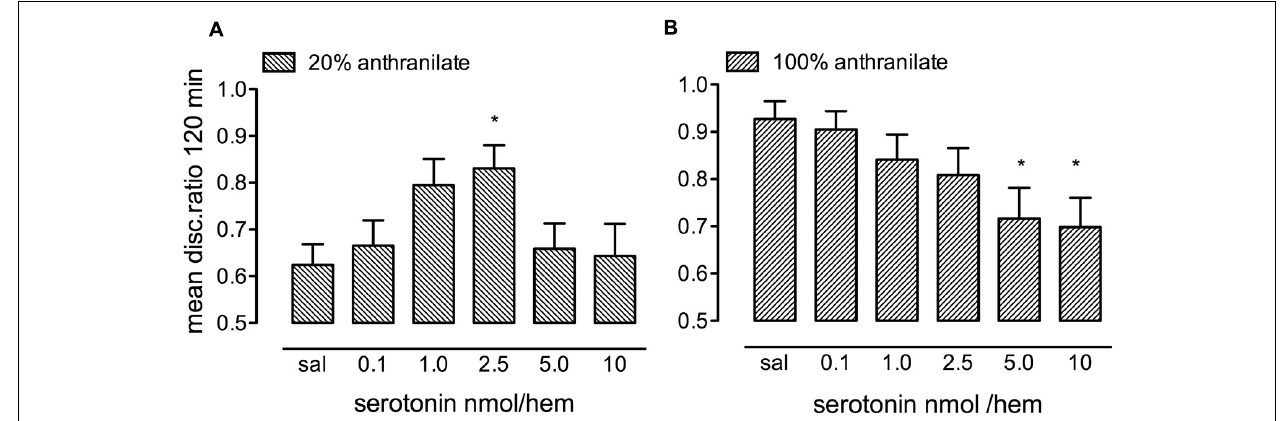
FIGURE 1 | Dose-response relationship for serotonin injected immediately after training. (A) After training on 20% anthranilate there was significant enhancement of consolidation with a dose of 2.5 nmol/hem.